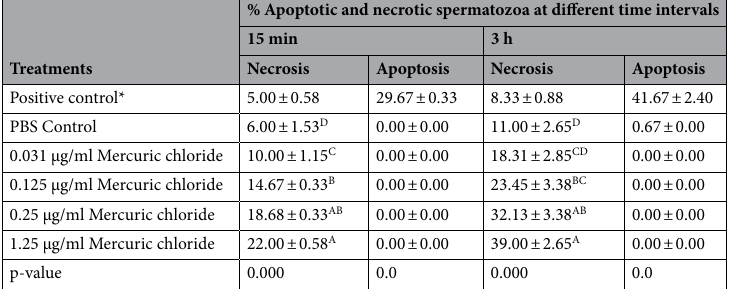
% Apoptotic and necrotic spermatozoa at different time intervals 15 min 3 h Treatments Necrosis Apoptosis Necrosis